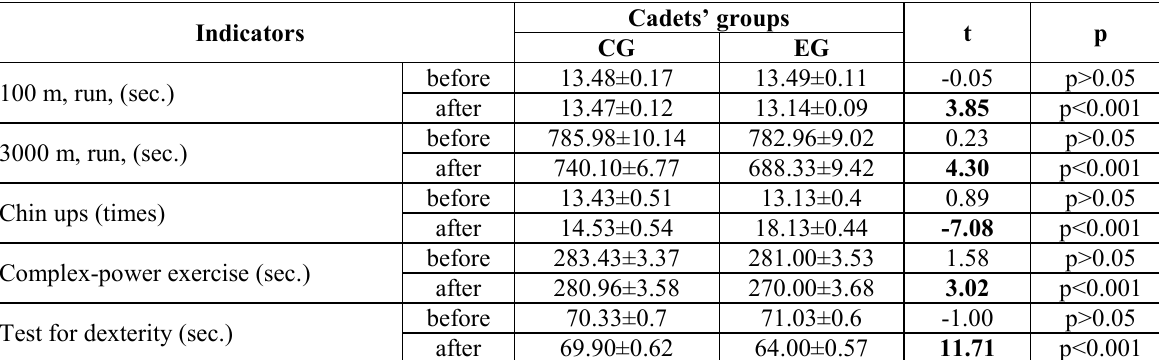
Indicators of physical fitness of control (n=30) and experimental groups’ cadets (n=30)before and after experiment,